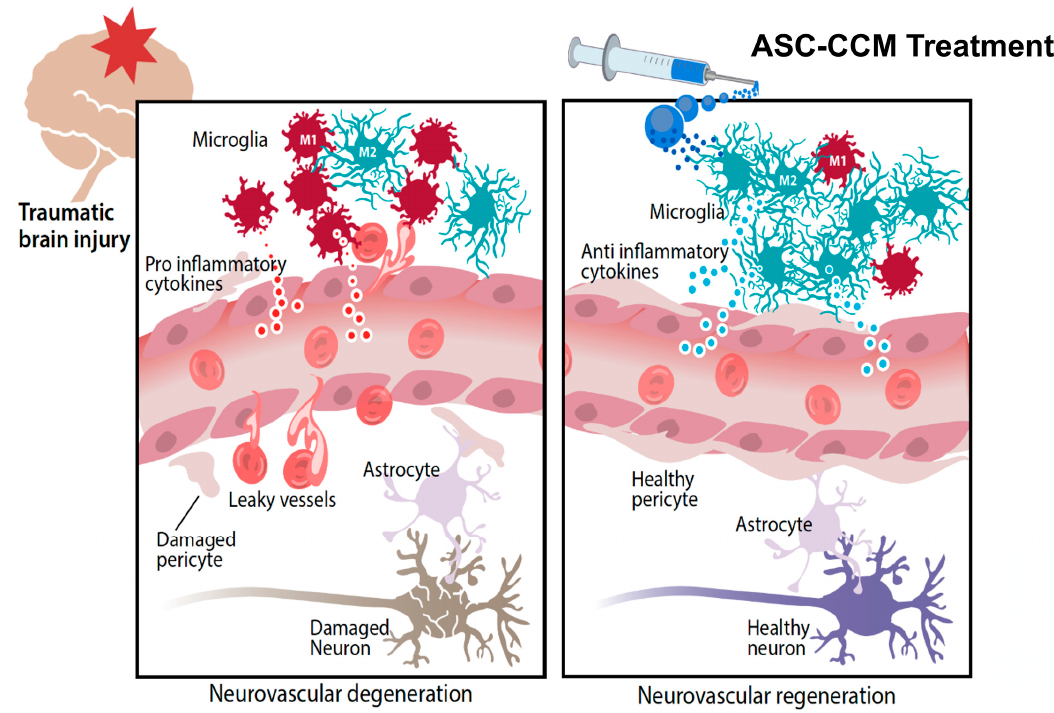
Figure 7. Hypothetical model of ASC-CCM therapy for visual deficits of mild traumatic brain injury (TBI). Activation and proliferation of microglial cells is a hallmark of ongoing neurodegenerative disease and has been shown to play a role in the adverse outcome following mild TBI. Microglia become polarized towards an M1 phenotype after TBI, releasing pro-inflammatory cytokines that result in neurodegeneration and vascular permeability, the hallmarks of visual deficits. On the other hand, treatment with ASC-CCM results in a restored M1-M2 balance leading to expression of anti-inflammatory cytokines and possibly regenerating pericyte–endothelial connections eventually leading to protection against visual deficits.